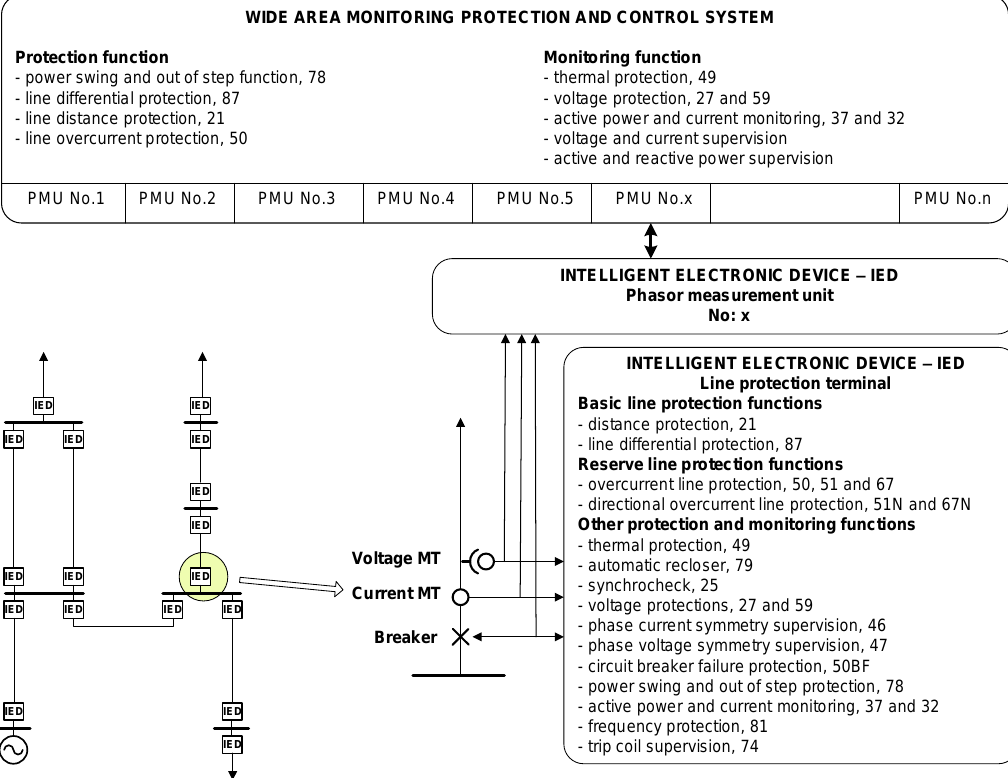
Figure 1. Principal block schemes of a wide area monitoring, protection, and control (WAMPAC) systems based on traditional transmission line relay measurement and protection system.